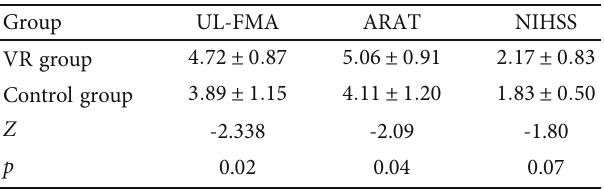
Figure 9: CNV amplitudes of the control group during nonparetic hand movement. Note: negative is plotted upwards. The 200 ms epoch prior to the S1 onset was the baseline CNV amplitude. The onset is at 0 ms point and is the S1 trigger time. Table 5: A summary of the changes in NIHSS, UL-FMA, and ARAT in the VR group and control